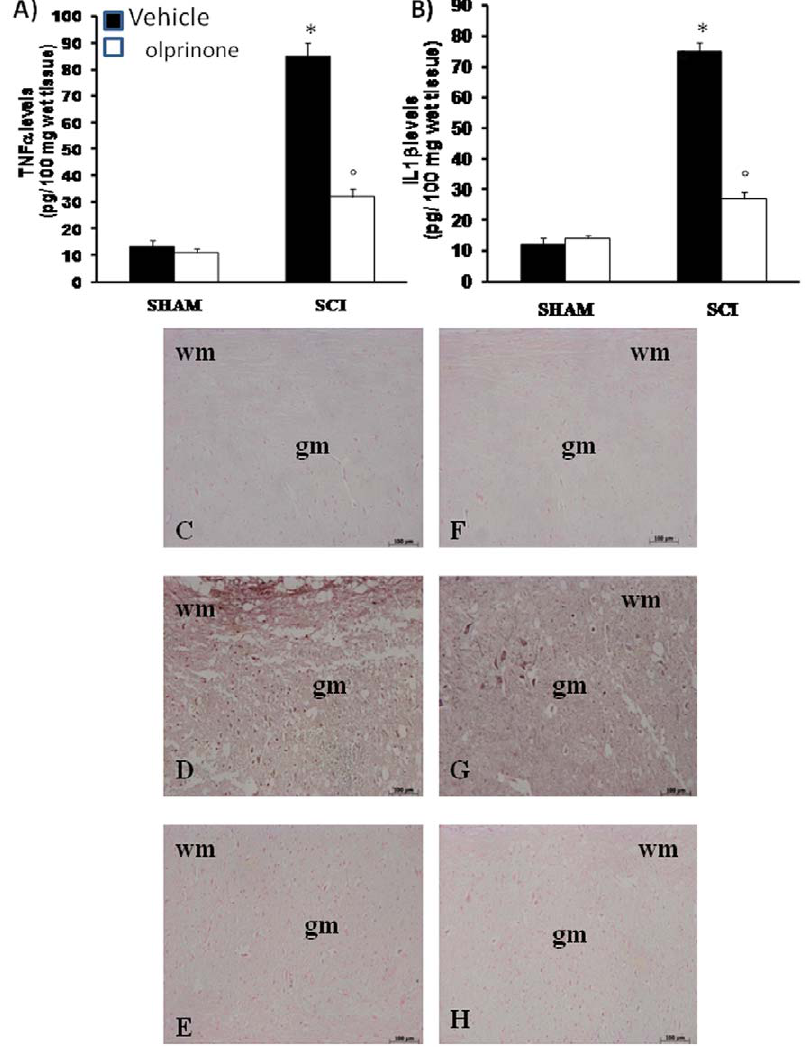
Figure 4. Effects of olprinone on pro-inflammatory cytokines. By ELISA measurement, TNF- a ( A ) and IL-1 b ( B ) levels were significantly increased in the spinal cord from SCI mice. On the contrary, olprinone treatment (0,2 mg/kg 1 h and 6 h after SCI induction) prevented the SCI- induced levels of these cytokines (A and B). In addition, spinal cord sections were processed at 24 h after SCI to determine the immunohistological staining for TNF- a and IL-1 b expression. A substantial increase in TNF- a ( D ) and IL-1 b ( G ) expression was found in inflammatory cells, in wm and gm of the spinal cord tissues from SCI mice. Tissue expression of TNF- a ( E ) and IL-1 b ( H ) were significantly attenuated in olprinone -treated mice in comparison to SCI animals. The assay was carried out by using Optilab Graftek software on a Macintosh personal computer (CPU G3-266).